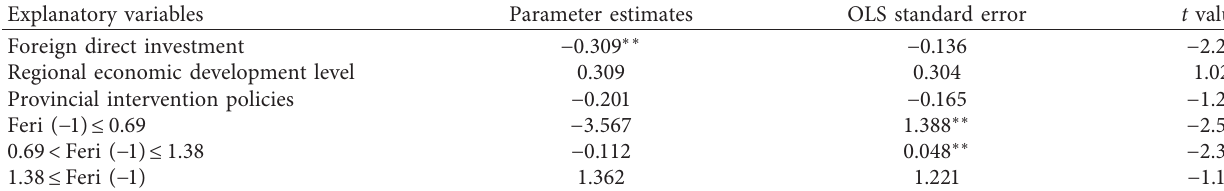
Table 9: Panel threshold regression